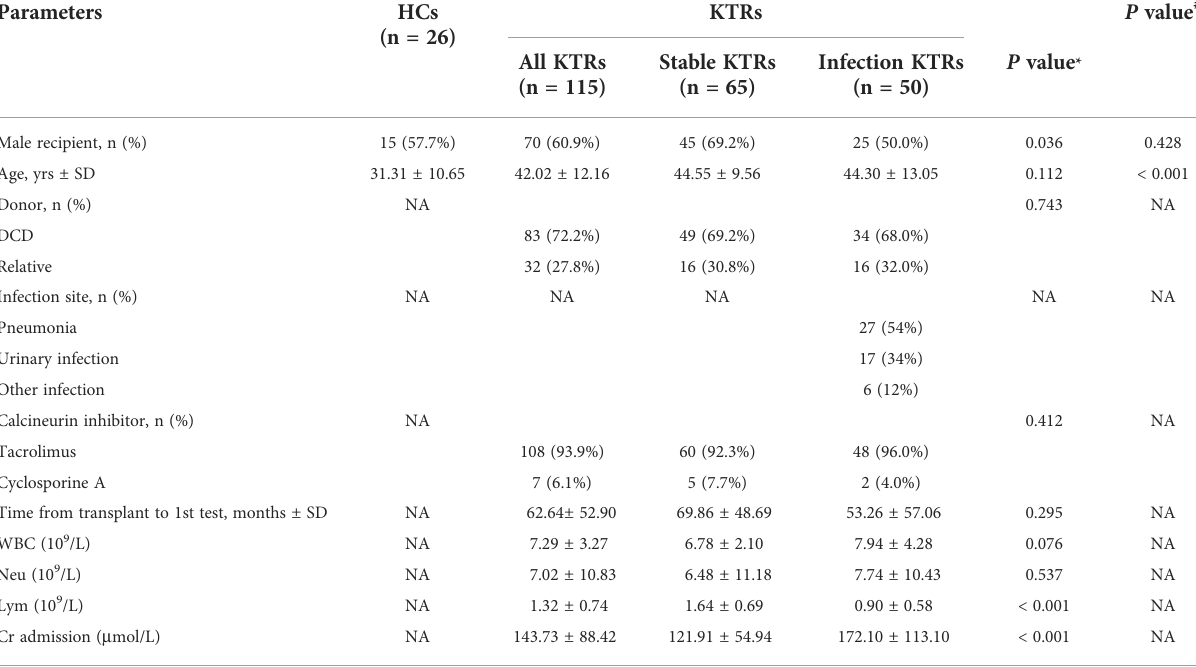
*Comparison between the stable KTRs and the infection KTRs. # Comparison among the three